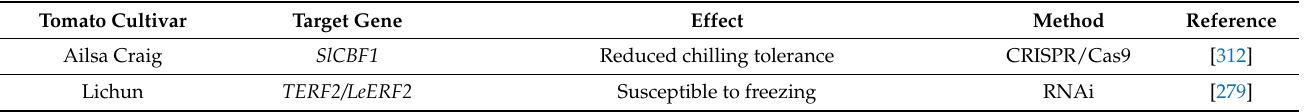
Table 2. Genome editing of tomato cultivars in response to abiotic stress tolerance. A putative Na+/H+ antiporter gene ( SlSOS1 ), AGAMOUS-LIKE6 (SlAGL6), Altered response to salt stress 1 (SlARS1), ASCORBATE OXIDASE (SlAO) , Basic region/Leucine zipper transcription factor ( SlbZIP1 ), BRASSINAZOLE RESISTANT1 (SlBZR1), Chilling-tolerance divergence1 (LeCOLD1), C-repeat binding factor (SlCBF1), Cys2/His2-type zinc-finger protein (SlZF3), DNA-binding with one finger 22 (SlDof22), Fructose 1,6 biphospahte aldolase (SlFBA1), Glutamate decarboxylases (SlGADs), GABA transaminases (SlGABA-Ts), Glutamate receptor-like (SlGLR3.3 and SlGLR3.5), Guanine nucleotide-binding protein alpha-1 subunit (LeGPA1), invertase inhibitor1 (SlINVINH1), JUNGBRUNNEN1 (SlJUB1), MADS-BOX transcription factor ( SlMBP11 ), MADS-BOX transcription factor (SlMBP8), MAP kinase1 (SlMPK1), MAP kinase3 (SlMAPK3), Mitochondrial Alternate oxidase 1a (SlAOX1a), MIXTA-like MYB transcription factor (SlMX1), non-expressor of pathogenesis-related gene 1 (SlNPR1), Phytol kinase (SlVTE5), Plant specific NAC Transcription factor (SlNAC11) , Plant specific Transcription factor (SlGRAS4), Proline-,lysine-,glutamic-rich protein gene (SpPKE1) , RING-H2 finger gene (ShATL78- Like), SUMO E3 ligase1 (SlSIZ1), Tomato 2-oxoglutarate-dependent dioxygenase gene ( SlF3HL ), Tomato Ethylene response factor genes (TERF2/LeERF2), Tomato osmotic sensitive-1 (tos1), Tomato salt sensitive-2 (tss2), uridine diphosphate glucosyltransferase (SlUGT75C1), Whirly1 (SlWHY1). Tomato